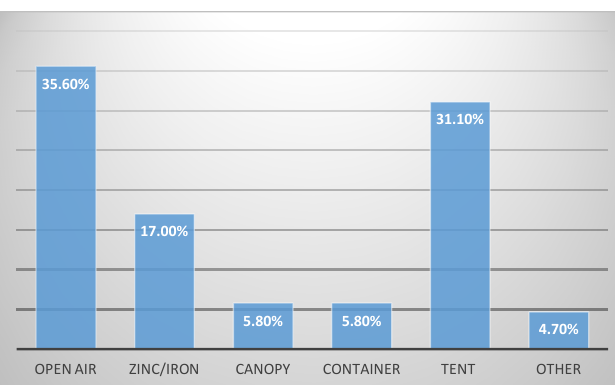
Figure 2. The structural status of the vending sites.